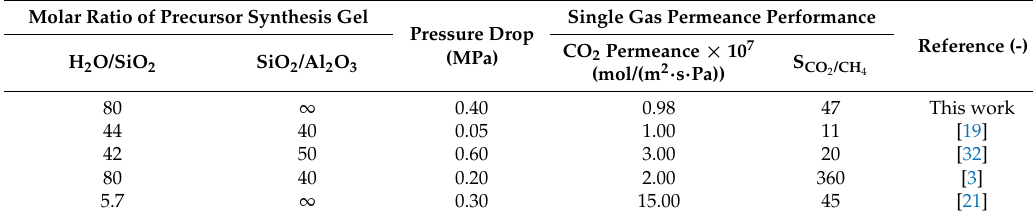
Table 2. Comparison of preparation conditions and single gas permeance performance of SSZ-13 zeolite membranes in